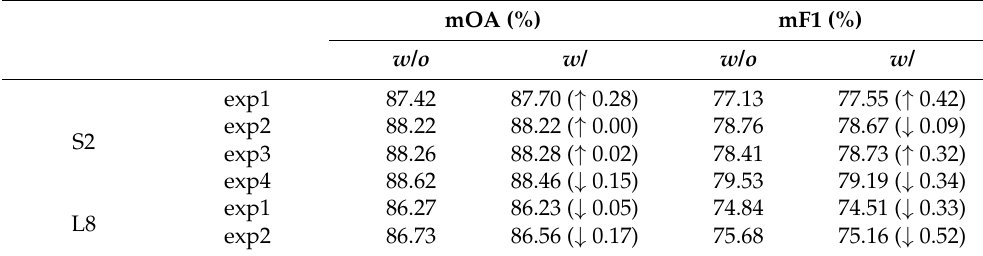
Table 5. The classification accuracy of different band/vegetation index settings 1 .